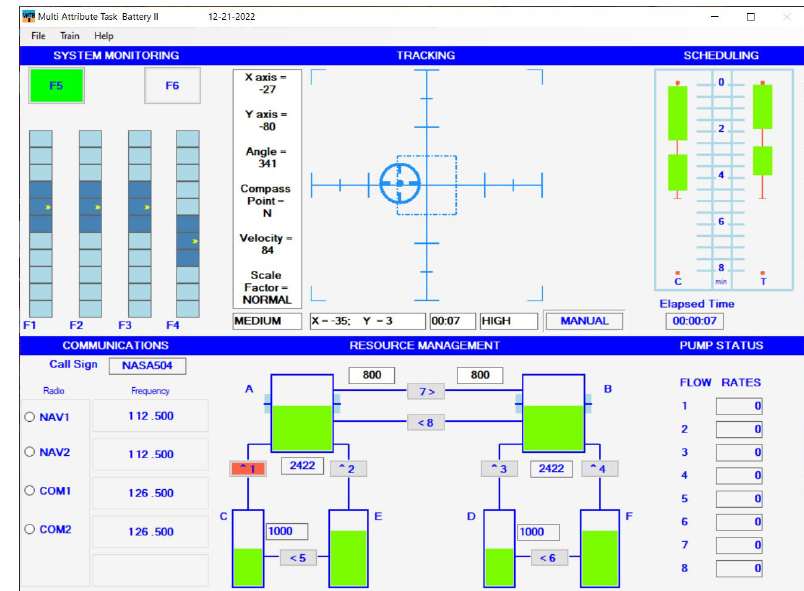
Figure 1. NASA Multi-Attribute Task Battery II (MATB-II).